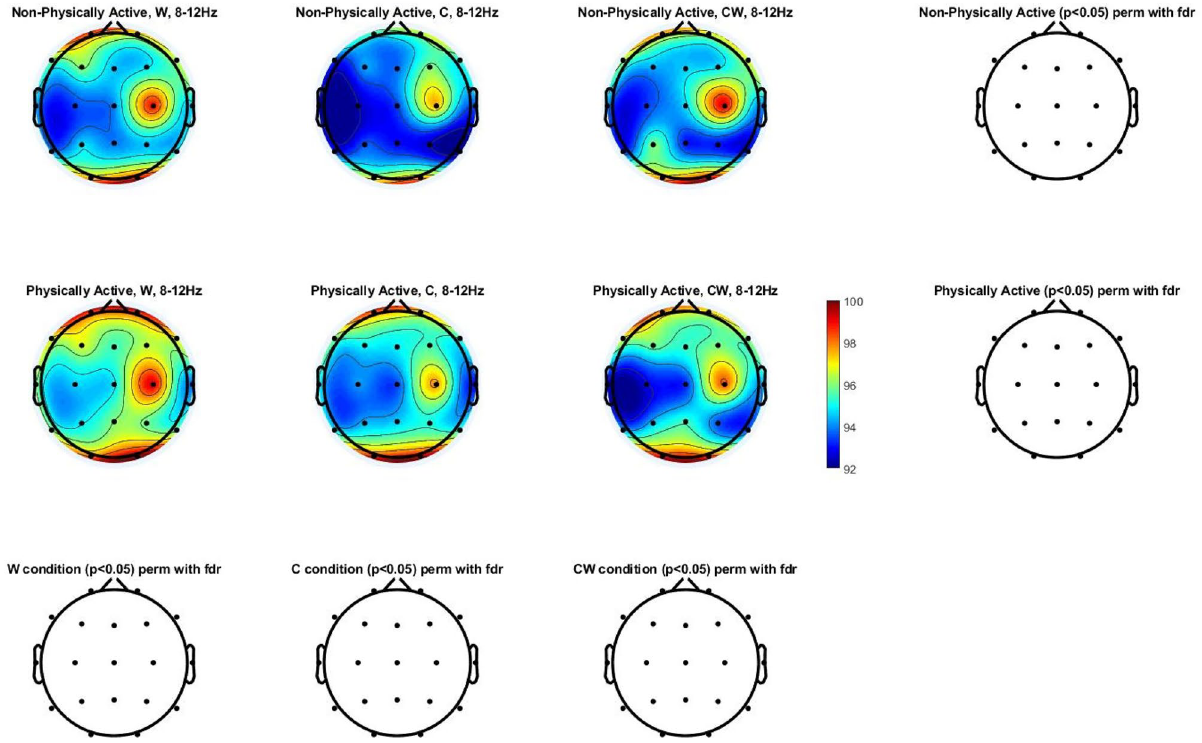
Figure 3. Alpha power spectrum (8–12 Hz) topographic maps in physically and non-physically active women with FM. Differences were not found (p > 0.05) in any of the scalp locations. W names of colors printed in black, C names different color patches, CW names color-word, where color-word are printed in an incongruous color ink (name the color of the ink instead of reading the